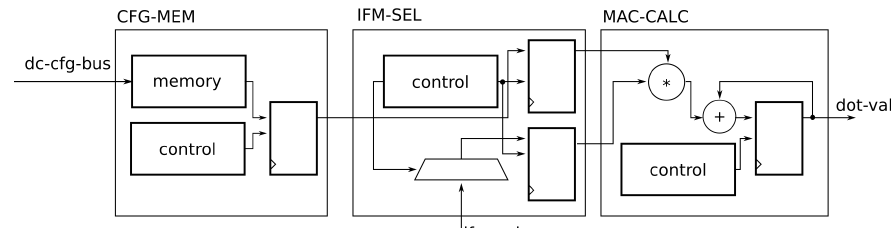
Figure 4. The DOT module